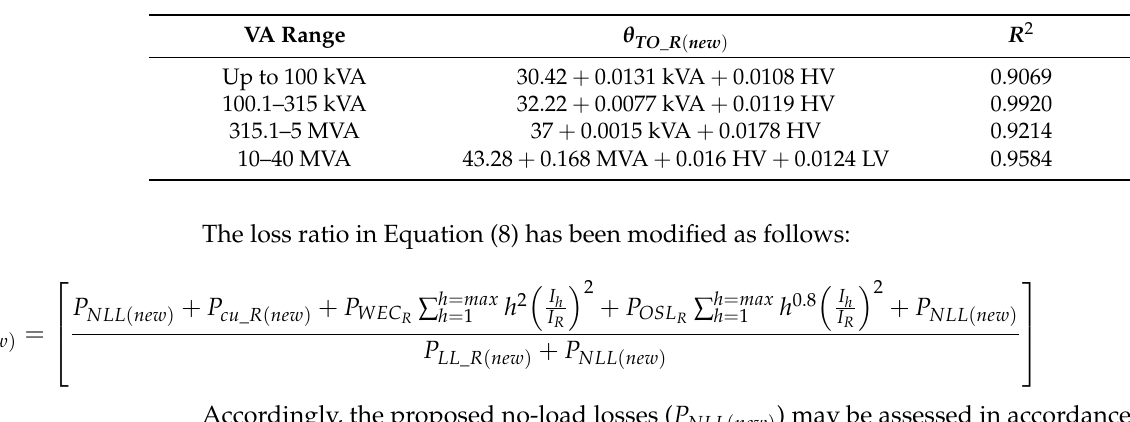
Table 2. Novel TOT models at rated conditions ( ◦ C).